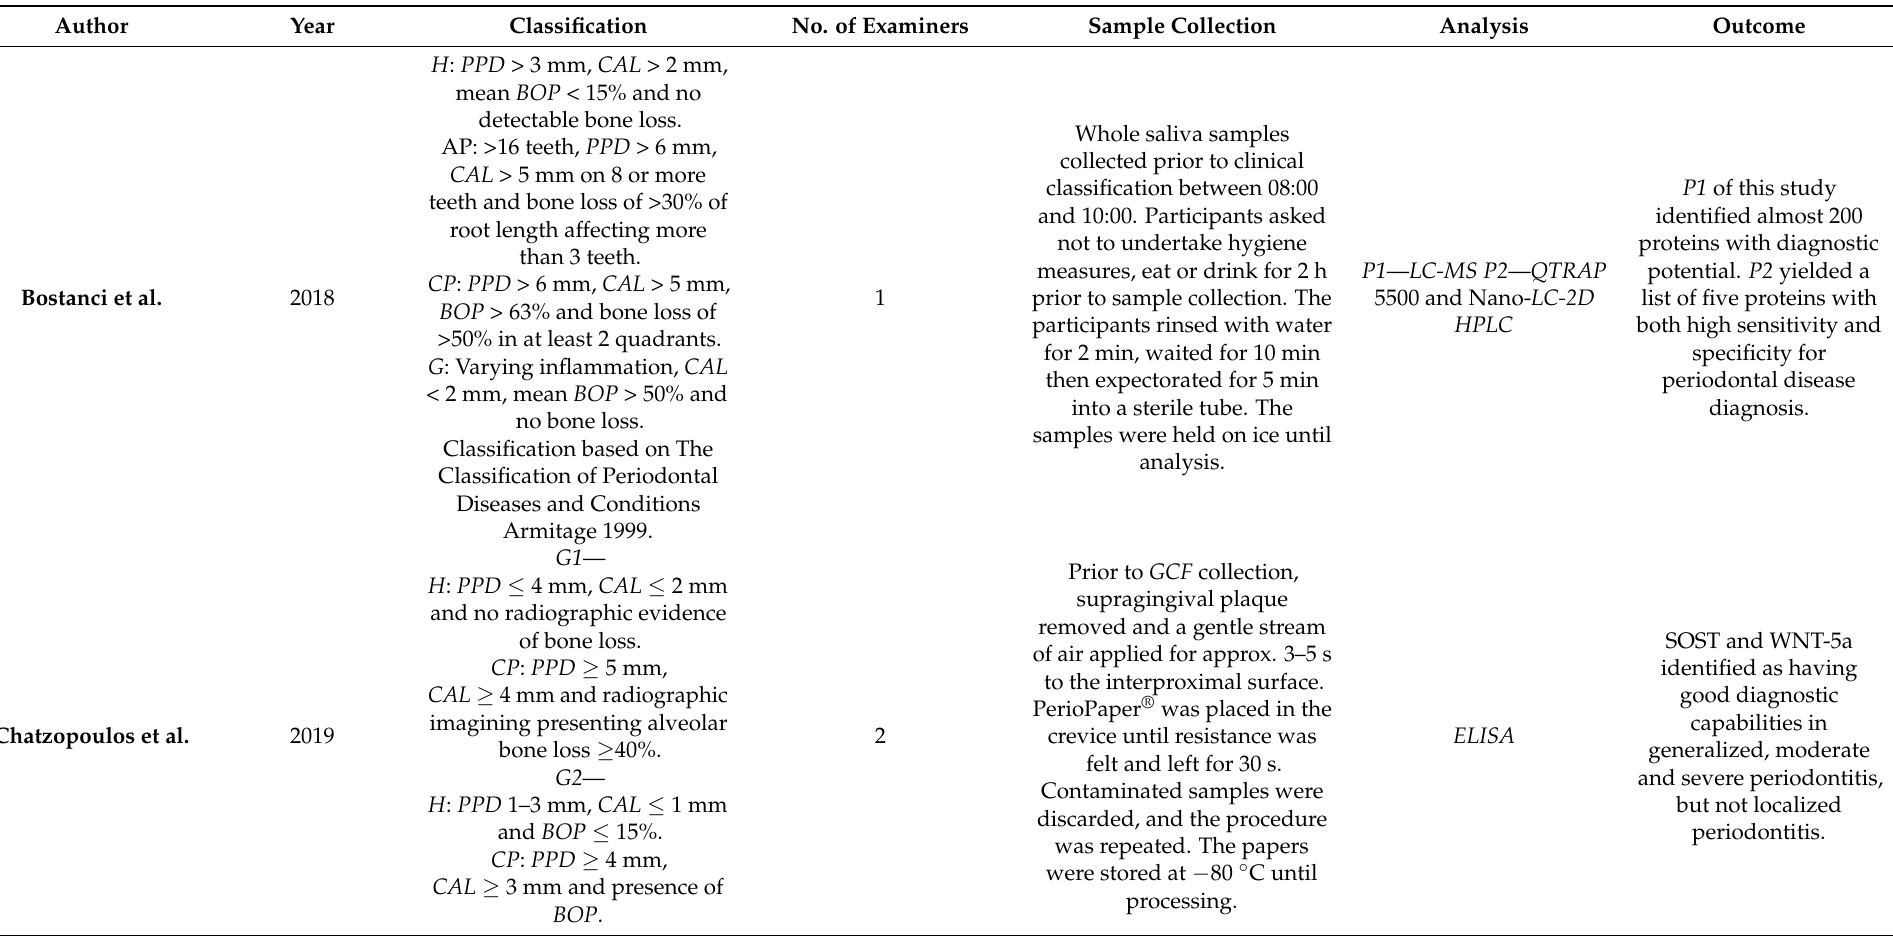
Table 7. Disease classification, number of examiners, sample collection method, sample analysis technique and brief outcome of studies analyzing protein